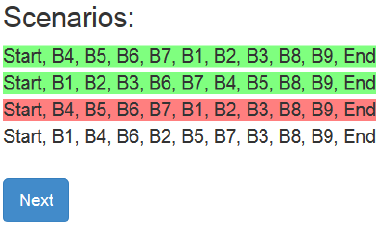
Figure 10. After a repeated scenario, the user performs a scenario of his choice, not respecting the rule of selection of activities from the proposed order.